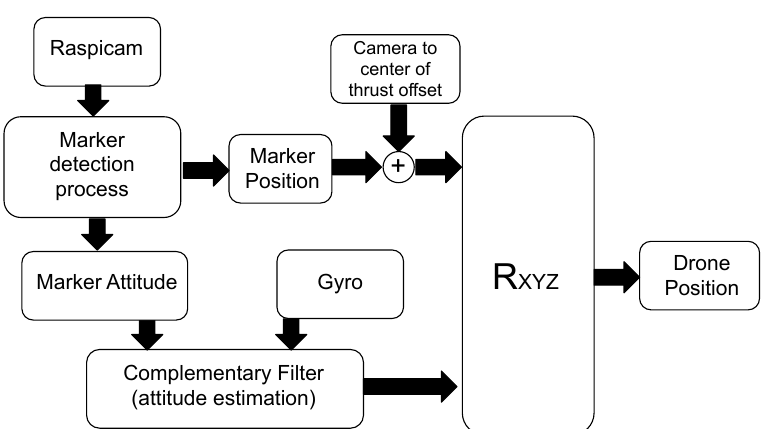
Figure 8. Schematic representation of the algorithm “Fixed Camera Frame Complementary Filter” (FCF-CF). The method adopts a complementary filter that fuses the stream data from the computer vision system and the gyroscope (here, the accelerator is not used). This allows to recover the information on the dynamics of the drone that is separately lost (not detected) by the two sensors. The complementary filter returns the estimate (cid:98) Φ of the drone attitude vector. In this way, by rotating of such an estimated angles the position of the marker (rectified by the offset vector Q off ), one can also derive the estimate of the drone